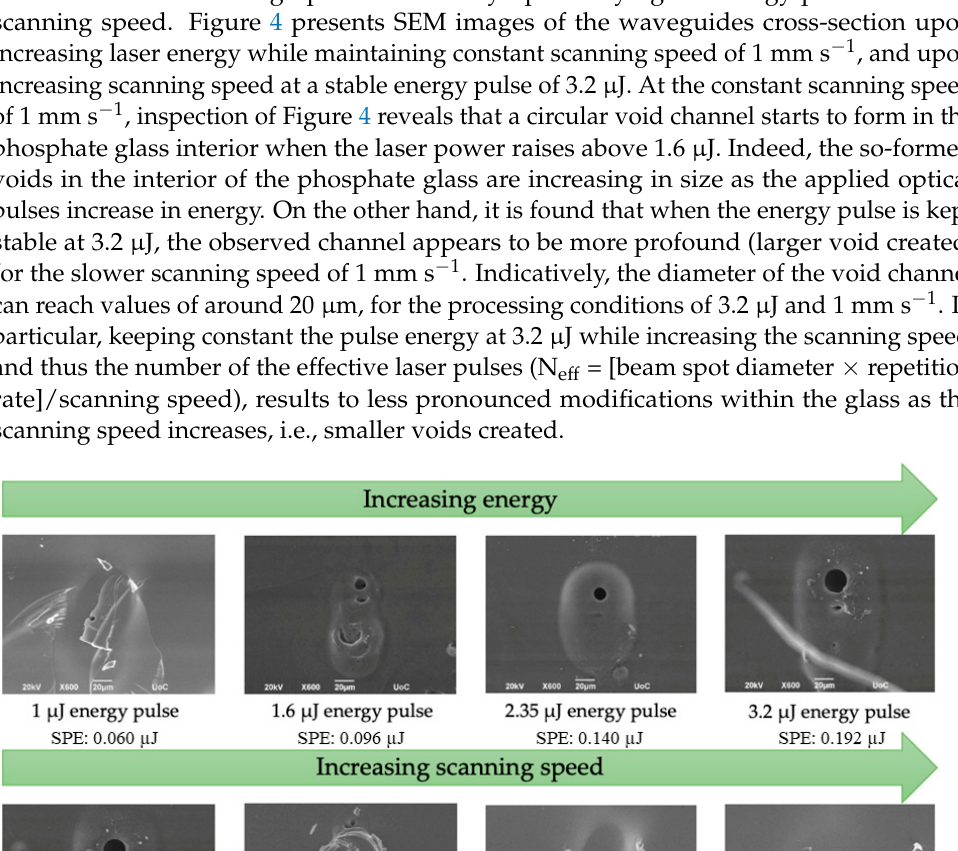
Table 2. Optical losses of W-lens and W-Obj fabricated waveguides.